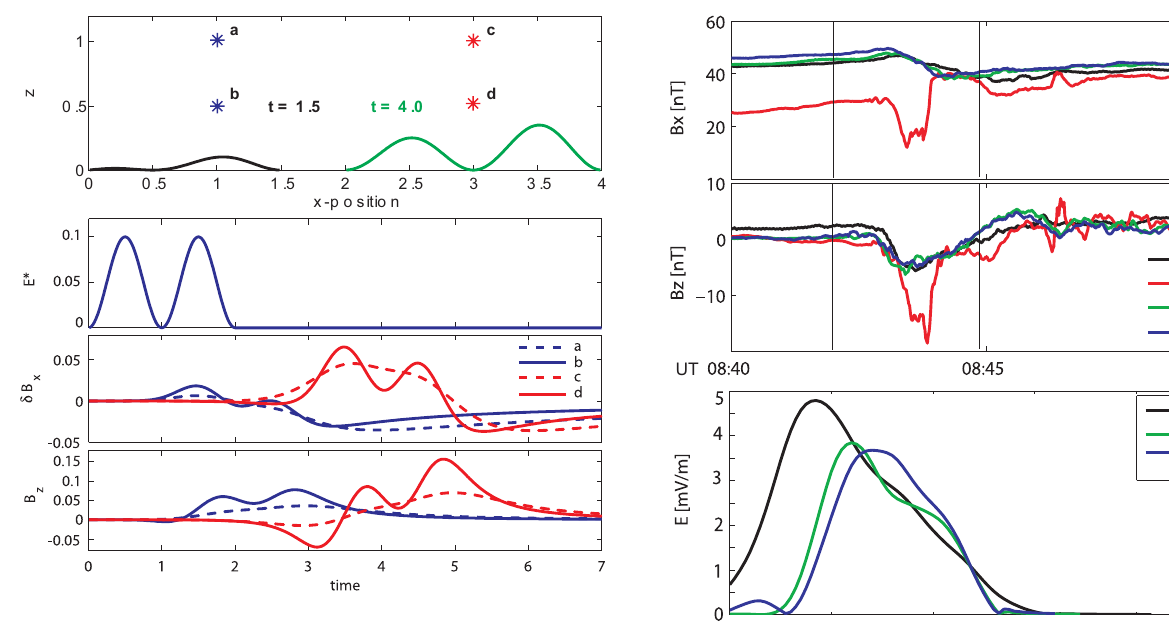
Fig. 30. Positions of artificial spacecraft a,b,c,d with respect to the outflow region (upper panel) produced by a double-pulsed recon- nection rate (second panel). Corresponding disturbances of δB x and B z observed by the artificial spacecraft are shown in the two lower panels. The magnetic field is normalized to B 0 , the velocity to the Alfv´en velocity v A , the time to the duration of the pulse t 0 , and the distance to v A t 0 .